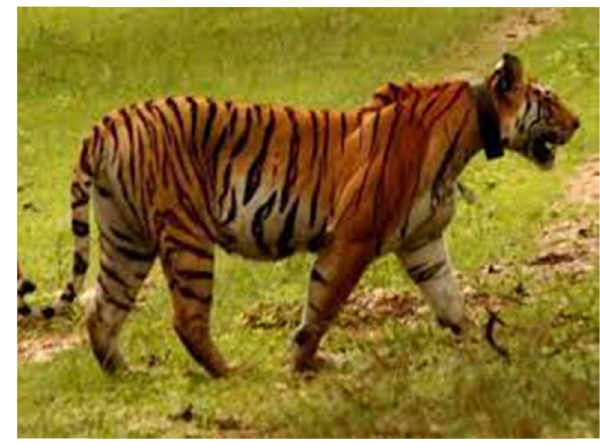
Figure 5: Tiger wearing a radio collar [ 4 ]